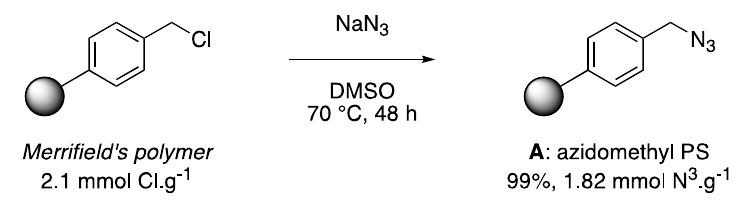
Polymers 2016 , 8 , 187 5 of 12 1'-[(1',2',3'-triazol-4'-yl)methyl-4-(pyrimidin-2-yl)piperazine-1-carboxylate]methyl polystyrene ( 3d ): Yellow powder. 1.37 mmol piperazine·g − 1 . ATR/FTIR: ν = 3039, 2935, 2870, 1706, 1591, 1502, 1438, 1556, 1298, 1242, 1132, 1092, 1054, 981, 800, 761, 703, 555 cm − 1 . 1'-[(1',2',3'-triazol-4'-yl)methyl-4-(pyridin-2-yl)piperazine-1-carboxylate]methyl poly-styrene ( 3e ): Brown powder. 1.37 mmol piperazine·g − 1 . ATR/FTIR: ν = 3037, 2938, 2864, 1705, 1601, 1485, 1437, 1382, 1285, 1235, 1171, 1128, 1053, 981, 837, 771, 703, 534 cm − 1 . 1'-[(1',2',3'-triazol-4'-yl)methyl-4-(benzyl-oxycarbonyl)piperazine-1-carboxylate]methyl polystyrene ( 3f ): Pale pink powder. 1.27 mmol piperazine·g − 1 . ATR/FTIR: ν = 3039, 2934, 2869, 1706, 1613, 1507, 1429, 1365, 1293, 1231, 1101, 1056, 1016, 980, 830, 763, 703, 546 cm − 1 . 1'-[(1',2',3'-triazol-4'-yl)methyl-4-(furan-2-carbonyl)piperazine-1-carboxylate]methyl polystyrene ( 3g ): Beige powder. 1.34 mmol piperazine·g − 1 . ATR/FTIR: ν = 3038, 2937, 2859, 1706, 1634, 1580, 1494, 1430, 1373, 1289, 1234, 1186, 1122, 1055, 1017, 843, 759, 703, 547 cm − 1 . 2.3. Characterizations by ATR/FTIR of Polymer-Supported Triazolic Piperazines Infrared analyses using the attenuated total reflectance technique (ATR/FTIR) were recorded as previously described for organic compounds ( vide supra ) Results appear in Figure 2, Section 3.1. 2.4. Metal Ion Extraction Method and Quantification Neutral aqueous solutions of metal salts were prepared with 50 mg of FeCl 3 ·6H 2 O (0.185 mmol), CuCl 2 ·2H 2 O (0.293 mmol), NiCl 2 ·6H 2 O (0.210 mmol), ZnSO 4 ·7H 2 O (0.174 mmol), and Pb(NO 3 ) 2 (0.151 mmol) in 1 L of distilled water. Aliquots of 250 mg of each polymer ( 3a : 0.342 mmol, 3b : 0.335 mmol, 3c : 0.302 mmol, 3d : 0.315 mmol, 3e : 0.315 mmol, 3f : 0.292 mmol, 3g : 0.307 mmol,) were incubated in triplicate with 20 mL (50 mg·L − 1 , 1 mg of salt) of each metal ion solution (3.70 µmol Fe 3+ , 5.87 µmol Cu 2+ , 4.21 µmol Ni 2+ , 3.48 µmol Zn 2+ , and 3.02 µmol Pb 2+ ) at 25 °C for 24 h. The suspension was then filtered on distilled water prewashed filter paper. Evaluation of the chelated metal was done by concentration measurement by atomic absorption spectrometry on a Perkin Elmer type PinAAcle 900 T, after calibration curves recording for all metals. The results, average of three experiments, were expressed as percentages of extraction of the metal (Figures 3 and 4, Section 3.3). 3. Results and Discussion 3.1. Synthesis and Characterization of Azidomethyl Polystyrene ( A ) and Propargyl Carbamate Derivatives of Piperazine 2a – g Following the method of Mioskowski et al. [37], Merrifield’s polymer was treated with an